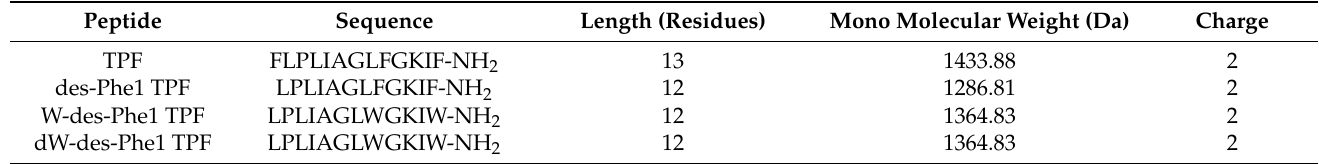
Table 1. Primary sequences of Temporin-PF and its